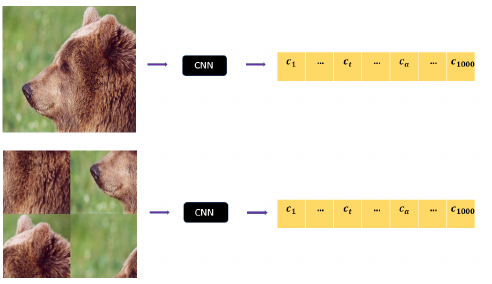
Figure 1. A 224 × 224 image I is divided into 4 patches of size 112 × 112 (top picture). The patches are shuffled around according to the permutation σ = ( 1,4 )( 2,3 ) ∈ S 4 , leading to sh σ (I ,112 ) (bottom picture). Both I and sh σ (I ,112 ) are sent to the CNN to extract the output